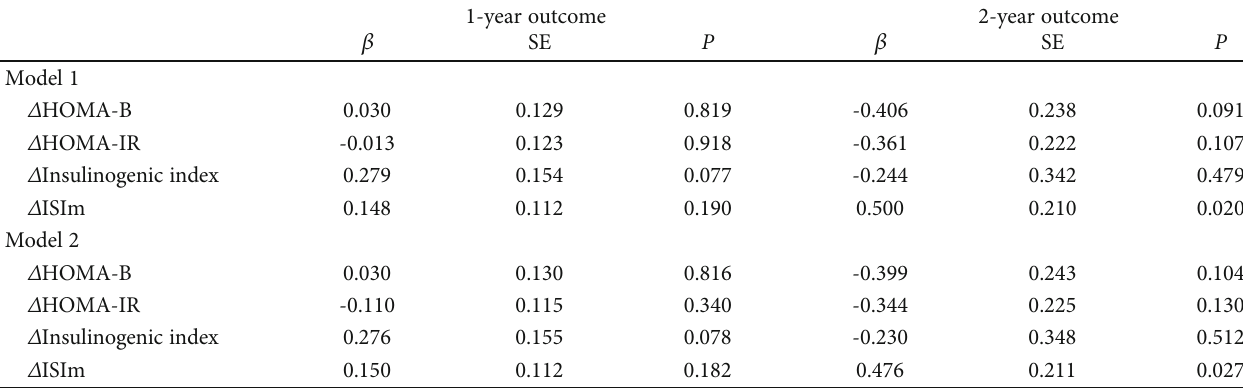
Table 6: E ff ects of the family history of diabetes on changes in insulin secretion and insulin resistance in the response of lifestyle